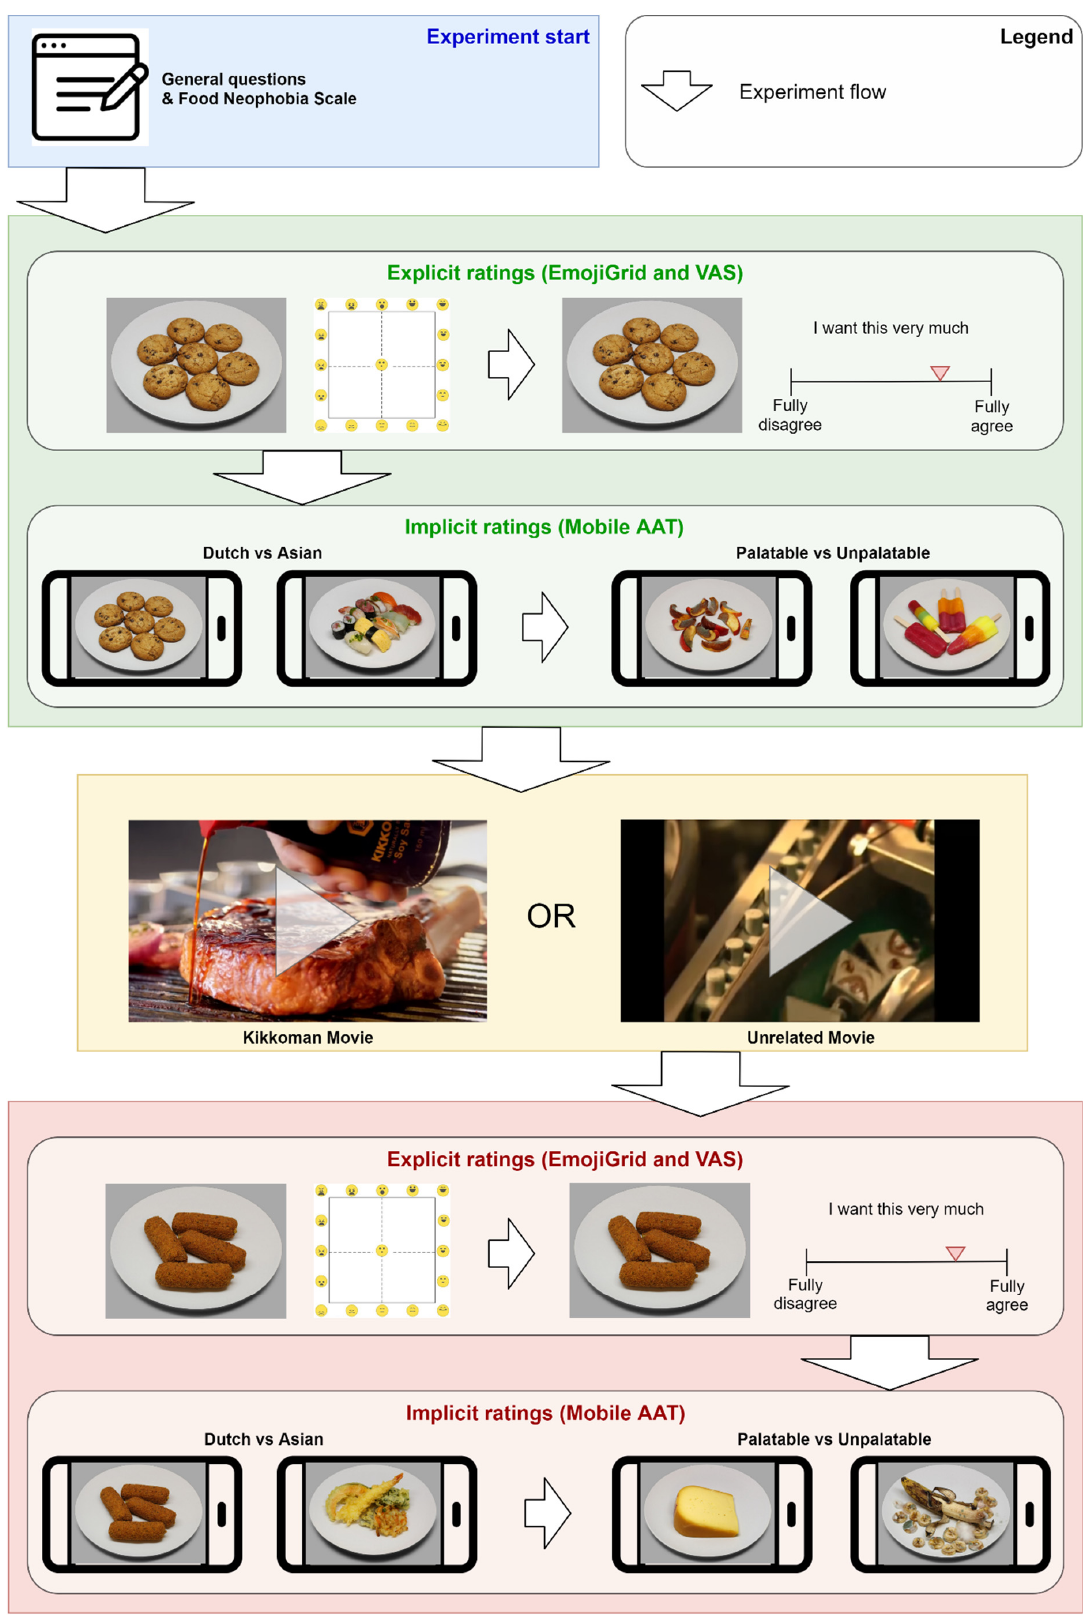
Figure 2. Schematic depiction of the experimental procedure.